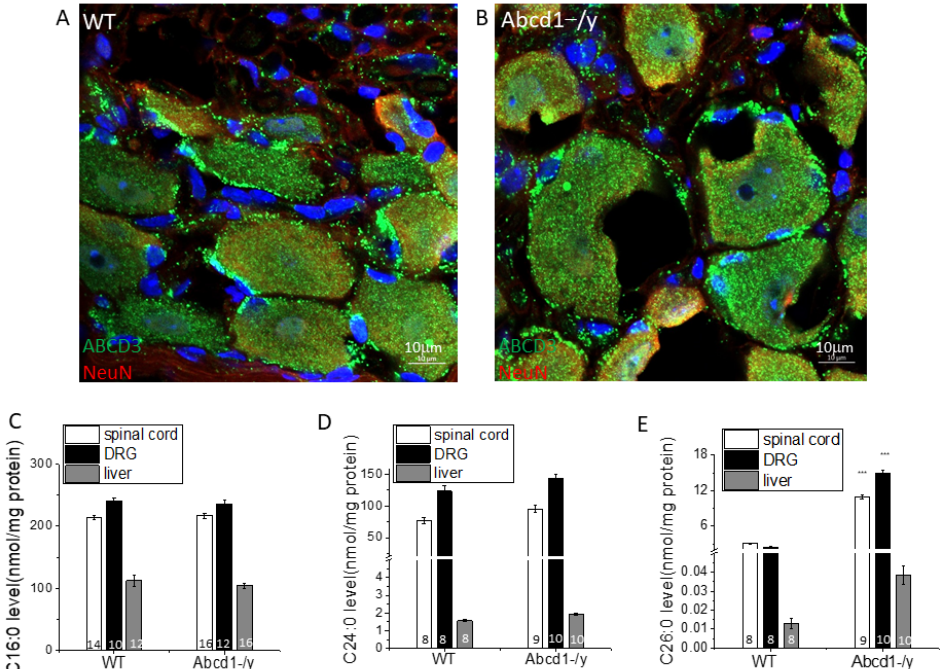
Figure 3. Peroxisome dysfunction in Abcd1 − /y mice leads to highest accumulation of very long chain fatty acids (VLCFA) within DRG. Peroxisomes are present in both SGCs and neurons as evident by ABCD3 staining. They are present in greater abundance within SGCs in both WT ( A ) and Abcd1 − /y ( B ), Bar = 10 µ m. The VLCFA C24:0 ( D ) and C26:0 ( E ) but not C16:0 ( C ) were higher in Abcd1 − /y mouse organs compared to wild-type measured by electrospray ionization mass spectrometry (ESI-MS) and reported as nmol/mg protein (n = 8–14 for WT and n = 9–16 for Abcd1 − /y , numbers are labeled in each Figure). Results were expressed as means ±SEM. *** p < 0.001 as compared with WT control.